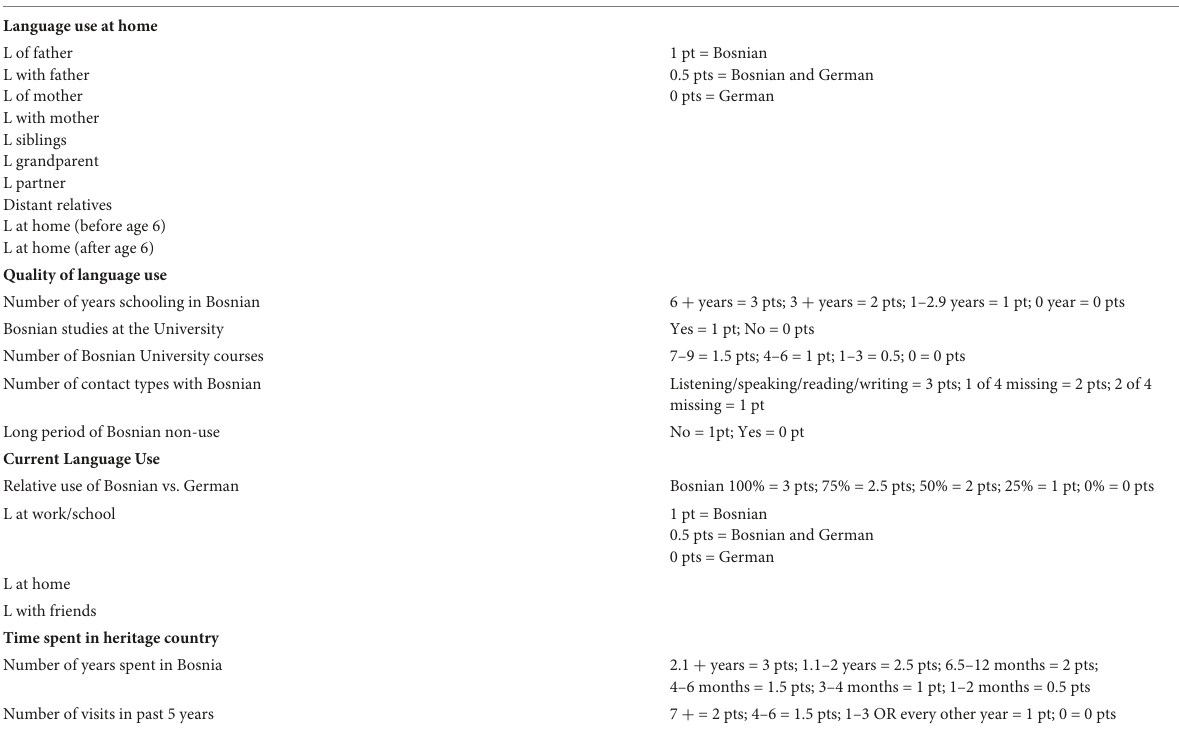
TABLE 4 Bosnian usage score